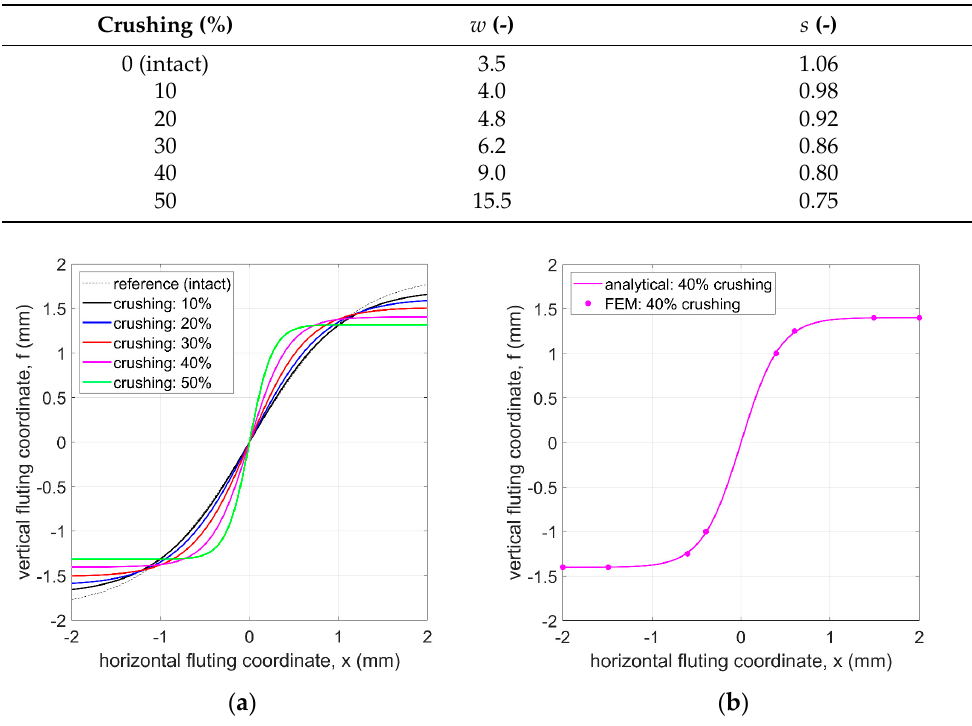
Table 2. Geometrical parameters of w and s for fluting to determine analytically the crushed geome- tries of corrugated cardboard used in the numerical part of this study.